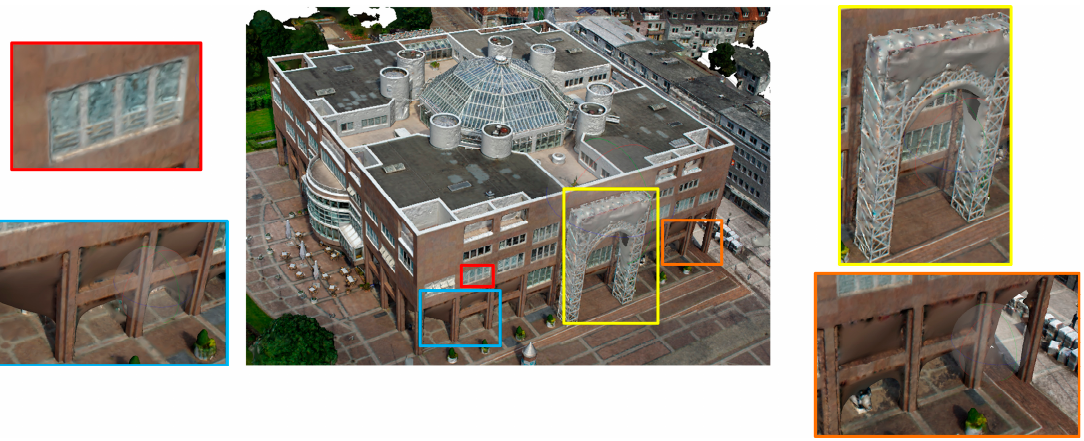
Figure 16. Model generated after the aerial–terrestrial images were aligned by ASIFT, GMS, and DFM.